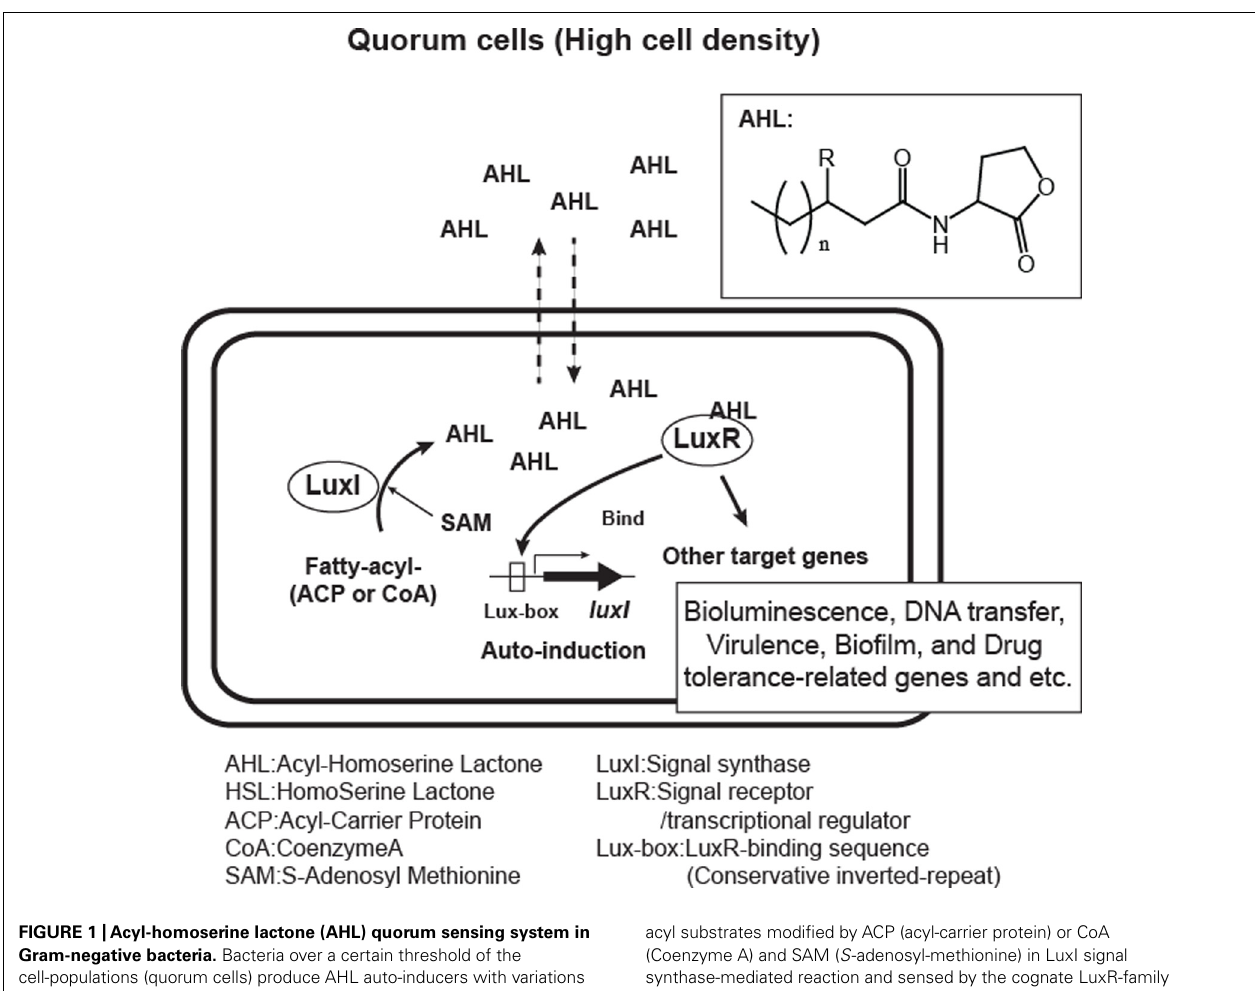
FIGURE 1 |Acyl-homoserine lactone (AHL) quorum sensing system in Gram-negative bacteria. Bacteria over a certain threshold of the cell-populations (quorum cells) produce AHL auto-inducers with variations in side chain ( n = 1, 2, 3 ... , R = H, O, or OH). AHLs are made from fatty